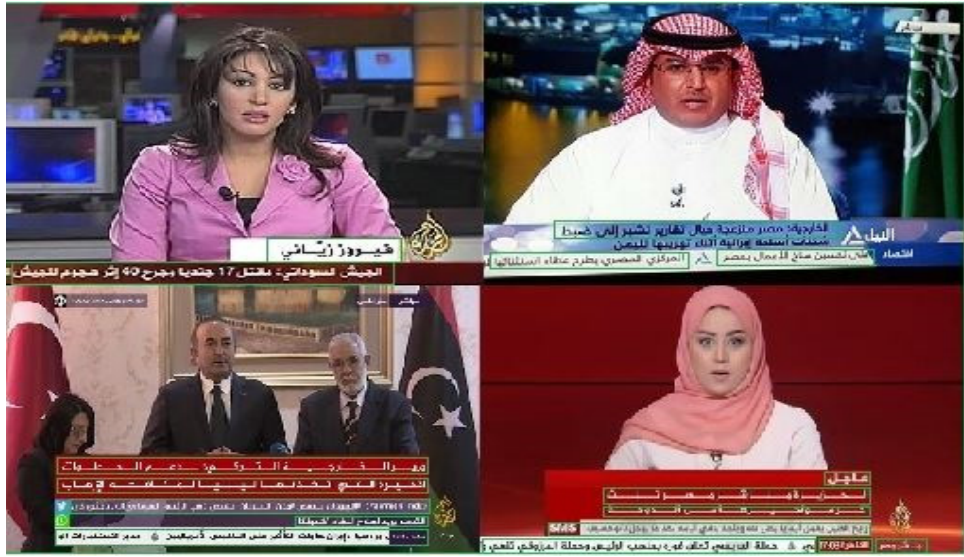
Figure 1. Arabic news channel dataset.